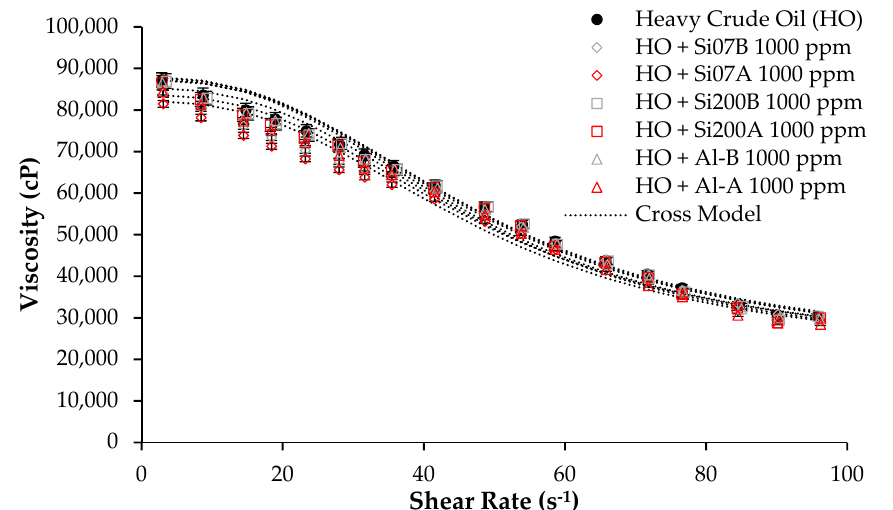
Figure 4. Viscosity as a function of shear rate at 25 °C for HO in the absence and presence of Si07, Si200 and Al nanoparticles after surface modification processes at 1000 mg/L and fitted with the Cross rheological model. Table 5. Estimated parameters of the Cross rheological models for crude oil in the presence of Si07, Si200 and Al nanoparticles after surface modification processes at 1000 mg/L and 25 °C. Si07B Parameter HO 1000 ppm µ ( ∞ , γ ) (cP)